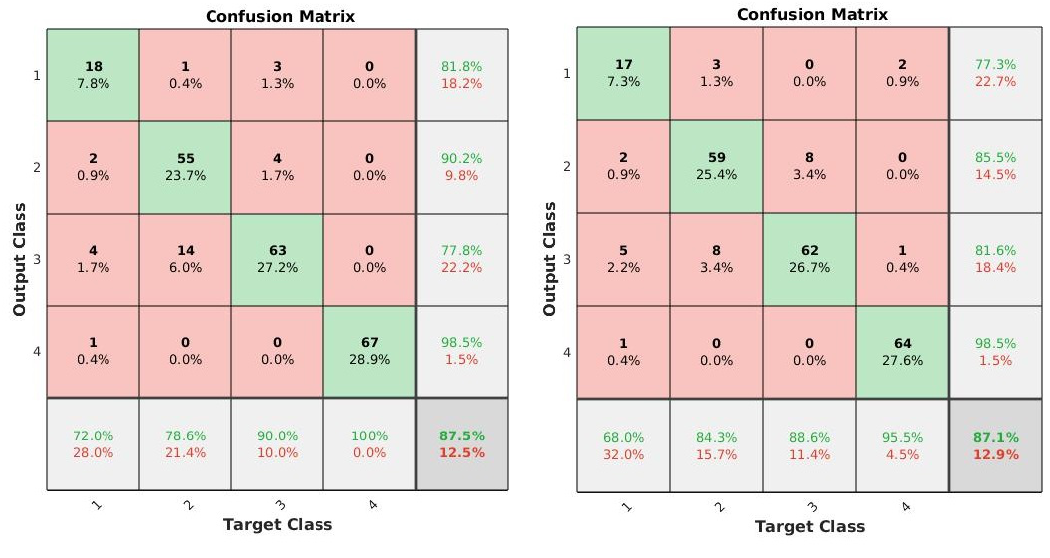
( b ) Exp 3 : Confusion matrix for the Hamiltonian CNNs on downsampled COVID Dataset with transfer learning.